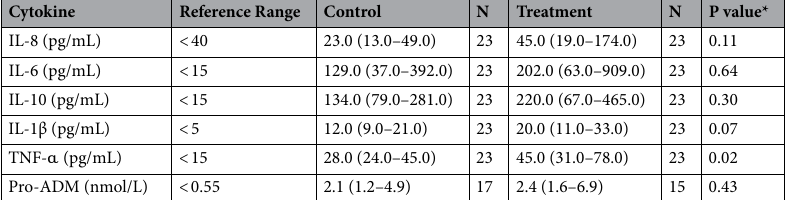
Table 2. Cytokines at enrollment in the study groups. Values are reported as median and 25 th –75th percentiles. N Number of samples. *P value from Wilcoxon rank-sum test.